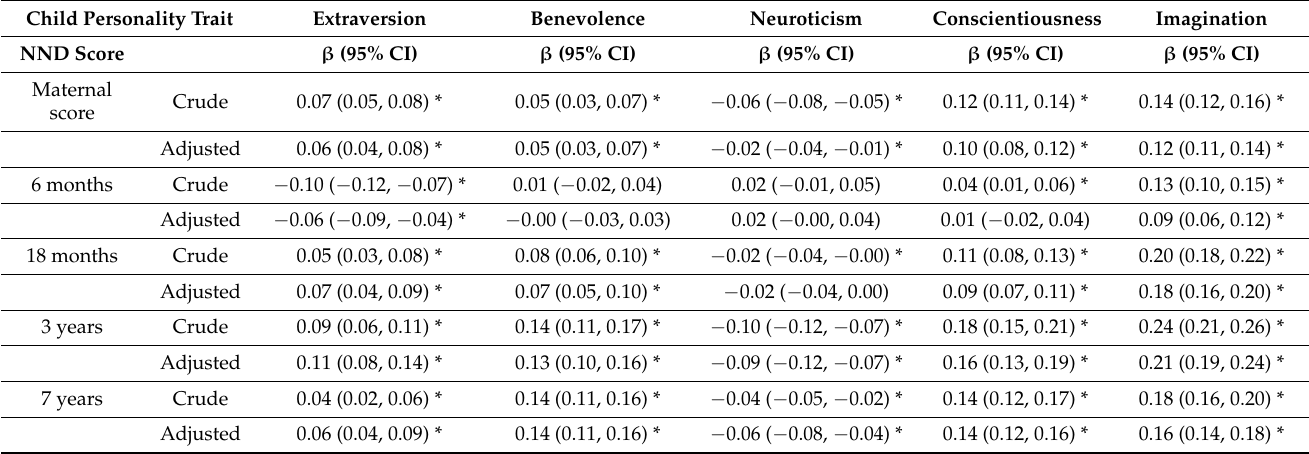
Table 6. Linear regression association between NND scores and child Personality traits 1 (Crude and adjusted 2